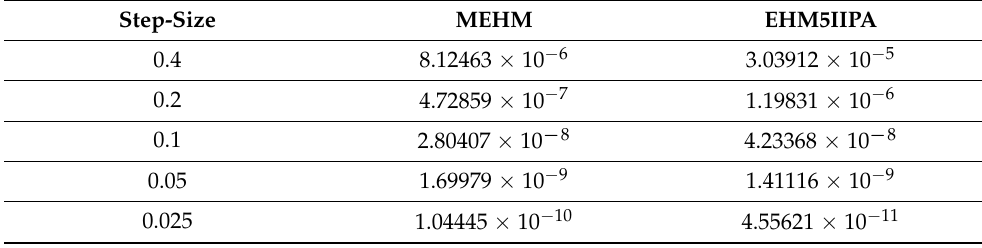
Table 2. Maximum global error in solving Problem 1.